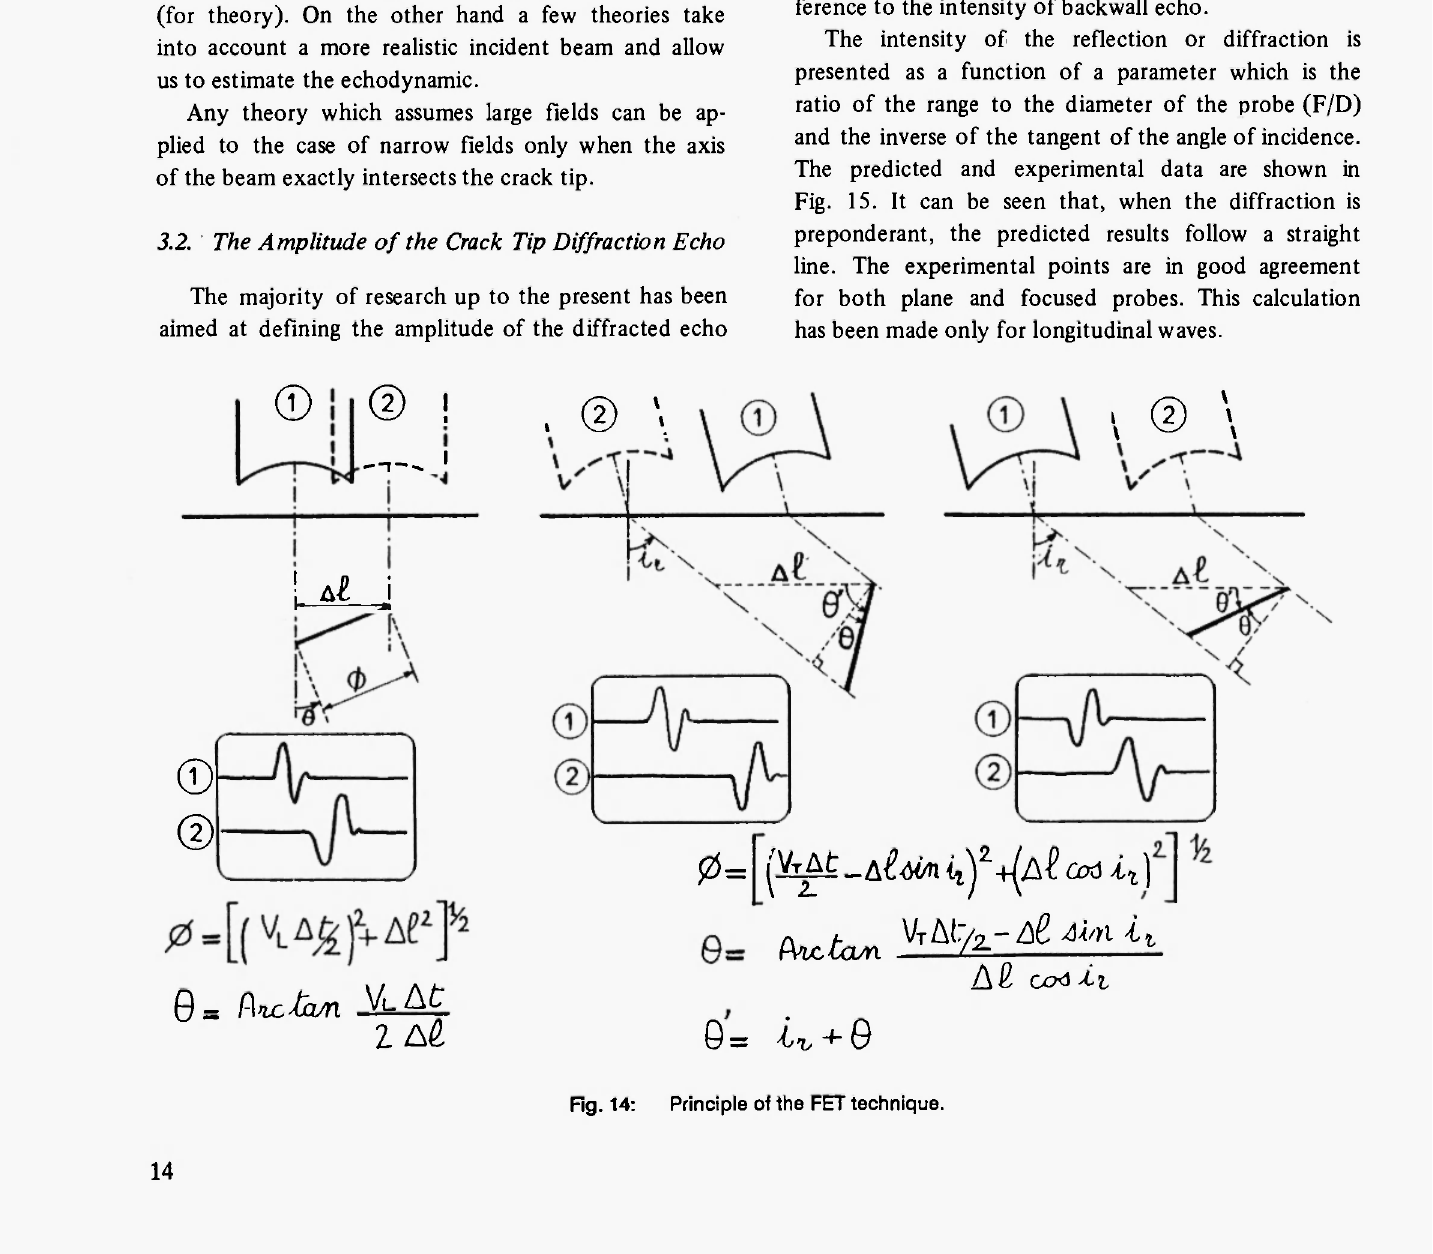
Fig. 14: Principle of the FET